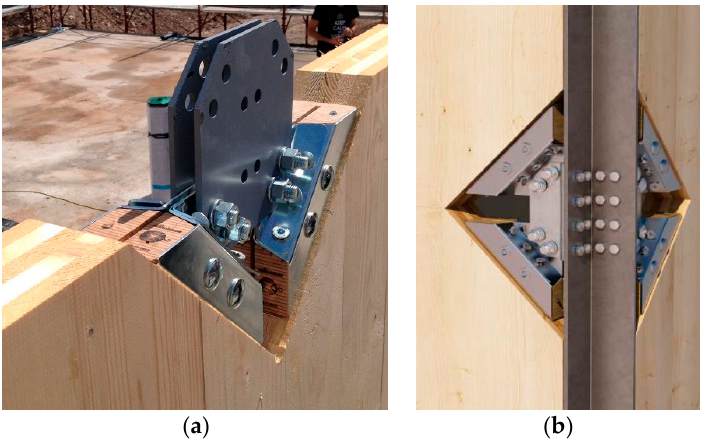
Figure 2. ( a ) Steel plate used to join two adjacent CLT panels equipped with X-Rad connectors (photo courtesy of Rothoblaas); ( b ) prototype of steel profiles used at the corners of a building.